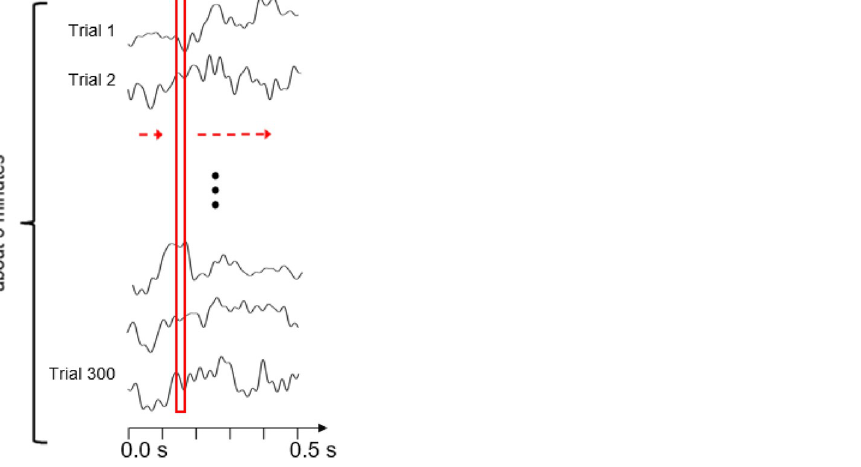
Figure 5. ITV calculation. The inter-trial variability (ITV) corresponds to the EEG standard deviation at a certain time point during stimulus presentation across repeated stimulus presentations. ITV is calculated for each time point during the stimulus (checkerboard or gray screen) presentation time window of 500 ms, as indicated by the red rectangle.